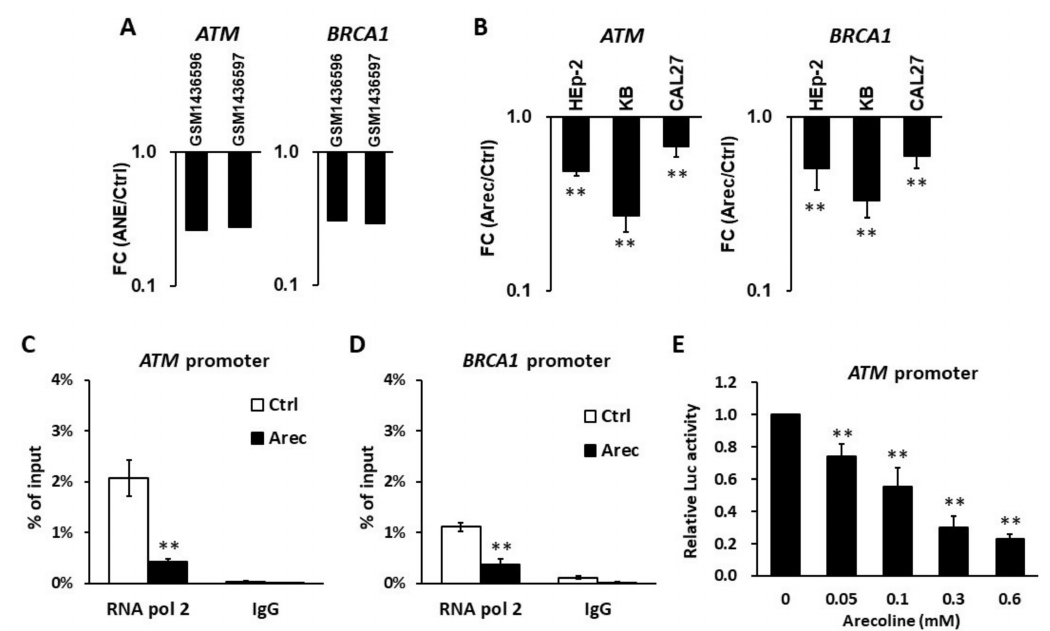
Figure 1. Areca nut extract (ANE) and arecoline inhibit the expression of ATM and BRCA1 . ( A ) The biological duplicated data (GSM1436696 and GSM1436697) of ATM and BRCA1 mRNA expression in ANE (5 µ g/mL, 72 h)-treated hGF cells were extracted from the Gene Expression Omnibus (GSE59414) [45] and were log-transformed. FC, fold-changed (ANE versus H 2